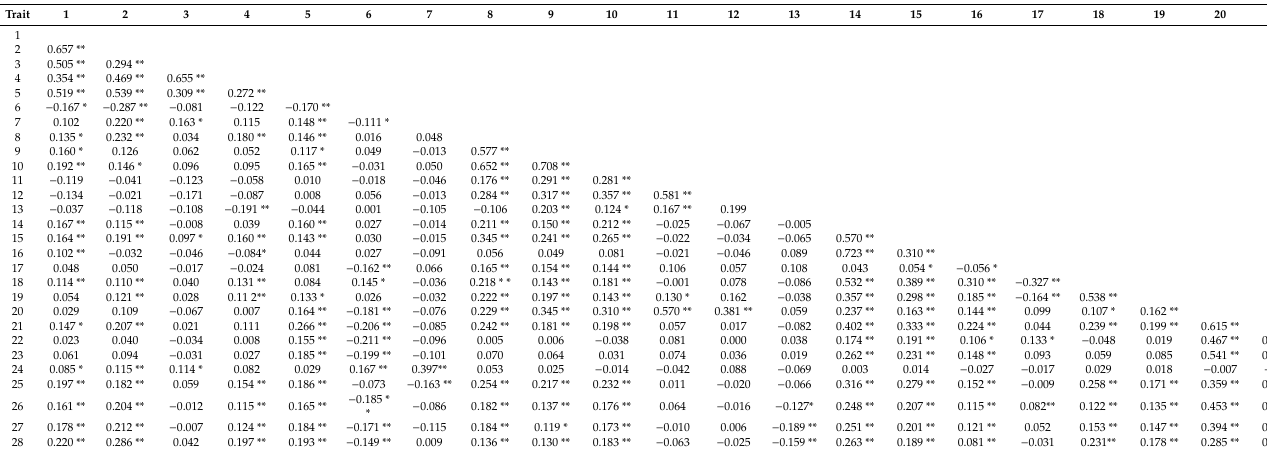
Table 6. Pearson correlation coe ffi cients of phenotypic traits of 180